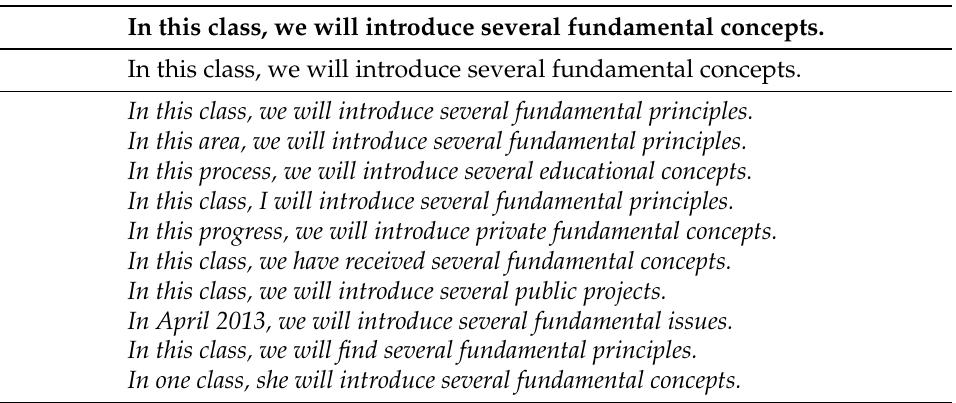
Table 1. Variational sampling. Example sentence (in bold ) used as the input to the VAT, with the decoded mean representation and samples from the latent distribution (in italics ).